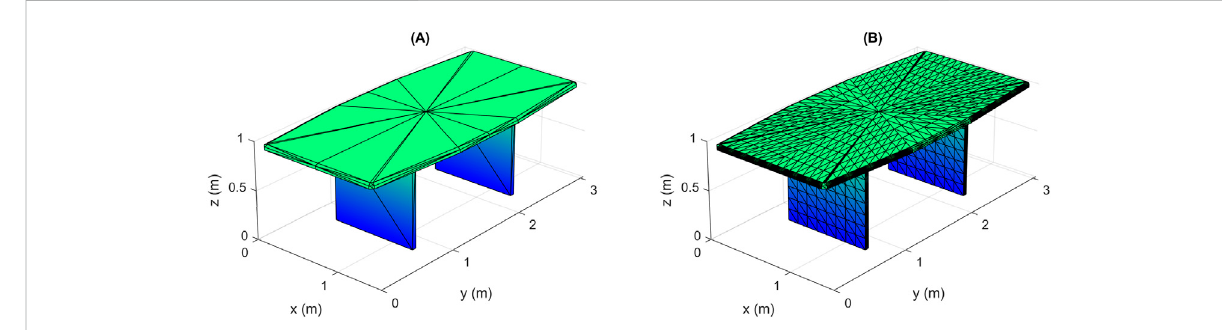
FIGURE 4 Division of elementary surfaces of large area into smaller ones: (A) original object, (B) resulting object after division.